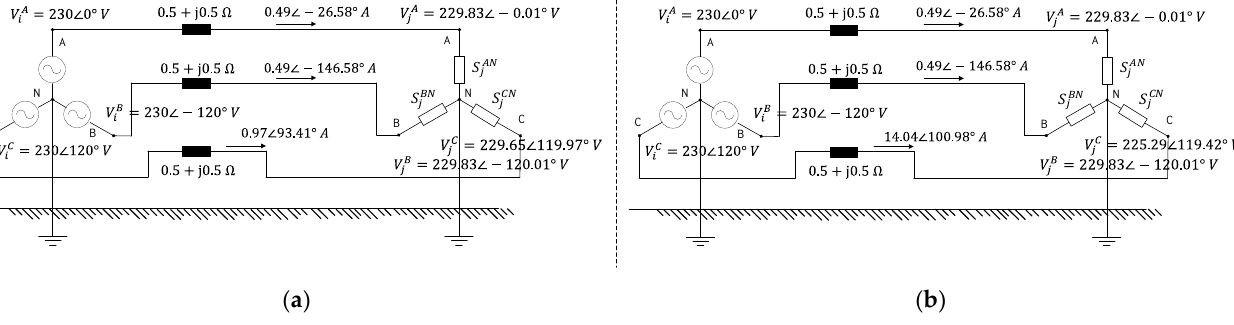
, S BN , and S CN are 100 + j 50, 100 + j 50, and 3000 + j 1000 W, respectively.